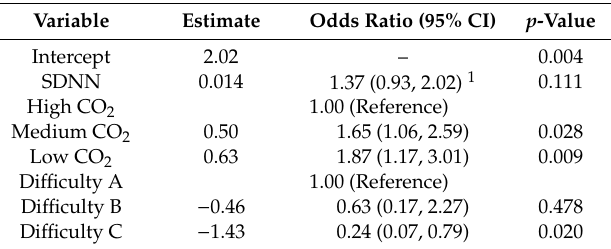
Table 4. GAMM results of SDNN, CO 2 condition and maneuver di ffi culty on passing a maneuver, controlling for examiner and flight profile number and treating pilot ID as a random e ff ect.